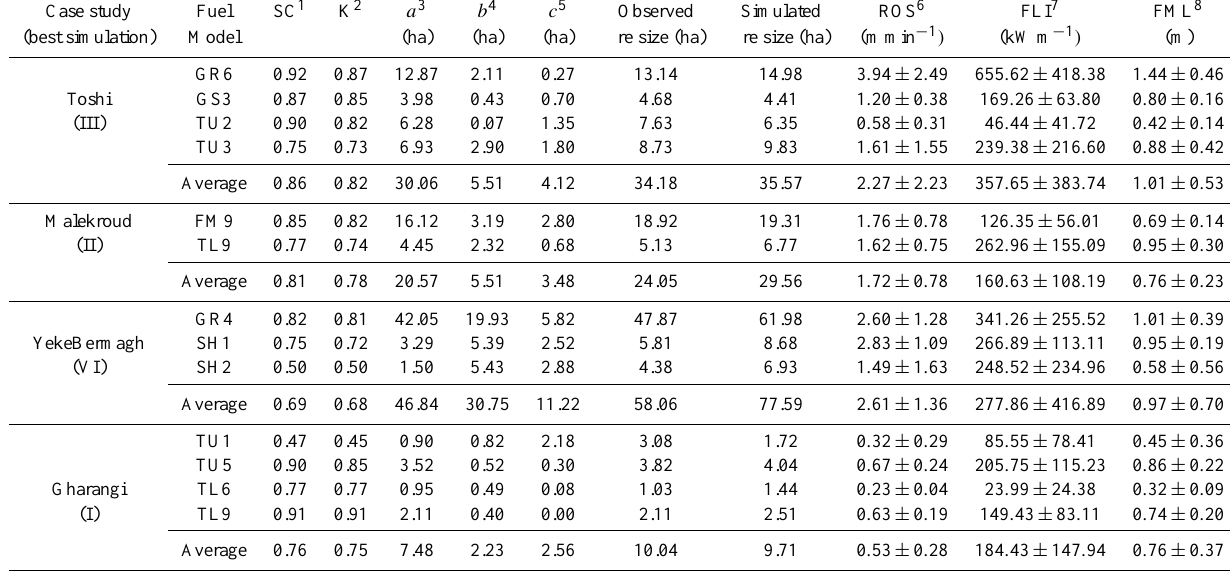
Table 5. Statistical evaluation of the best FARSITE simulation (III for Toshi, II for Malekroud, VI for YekeBermagh and I for Gharangi; Table 4) for each case study. Mean values ( ± SE) of the simulated ROS, FLI and FML are also reported. Case study